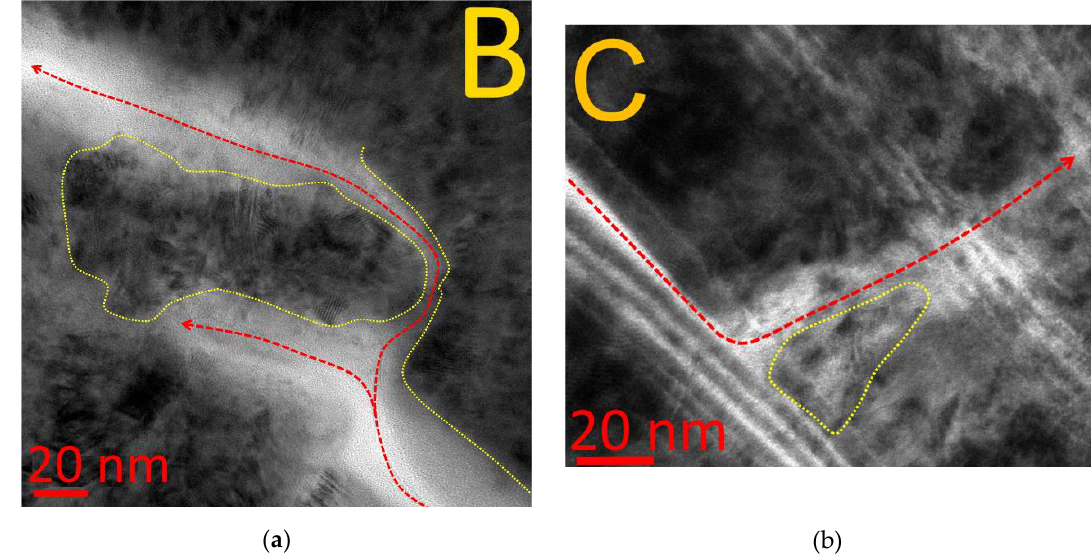
Figure 8. Pattern of crack propagation through the structure of the nanolayer coating. ( a ) Area B—crack division, ( b ) Area C—fracture direction transformation.